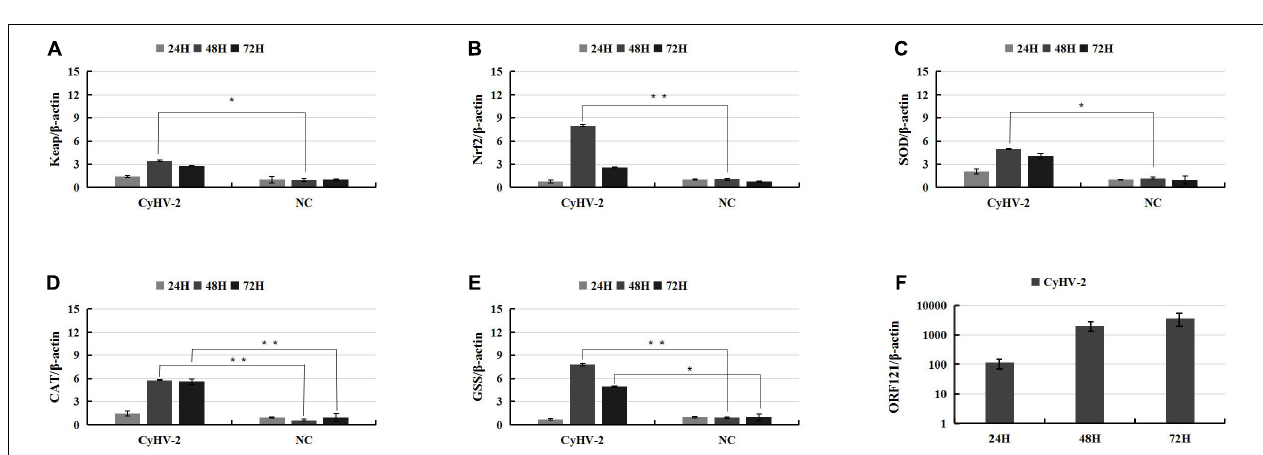
FIGURE 2 | CyHV-2 induces expression of key genes of Nrf2 signaling pathway in RyuF-2 cells. Quantitative real-time RT-PCR analysis was performed to compare the transcriptional expression levels of Keap1 (A) , Nrf2 (B) , SOD2 (C) , CAT (D) , GSS (E) and viral ORF121 (F) in infected cells. The mRNA level was normalized against housekeeping gene β -actin. Mock infected cells served as negative control. Similar results were obtained from three independent experiments. Data were represented as Means SD. * P < 0.05, ** P <